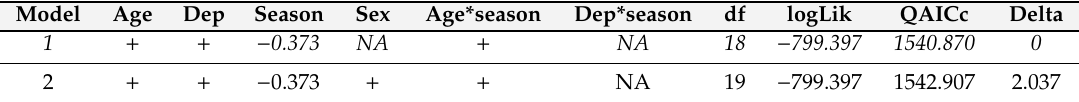
Table A1. QAICc of the two best models retained by the dredge function regarding c-LISA seroprevalence (i.e., lowest QAICc in a delta of two). The more parsimonious model is model 1 ( in italics ) and was finally retained.